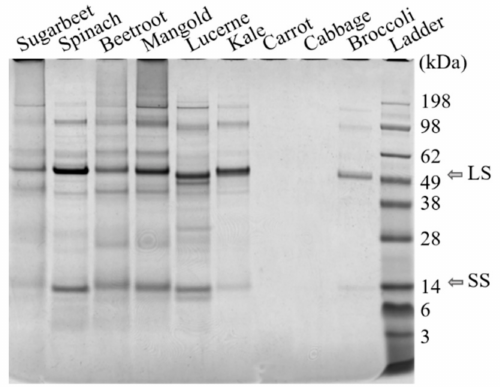
Figure 3. Results of SDS-PAGE analysis of freeze-dried white protein isolates (S4, see Figure 2) dissolved in water. The RuBisCO subunits are at ~55 kDa and ~14 kDa. LS: large subunit, SS: small